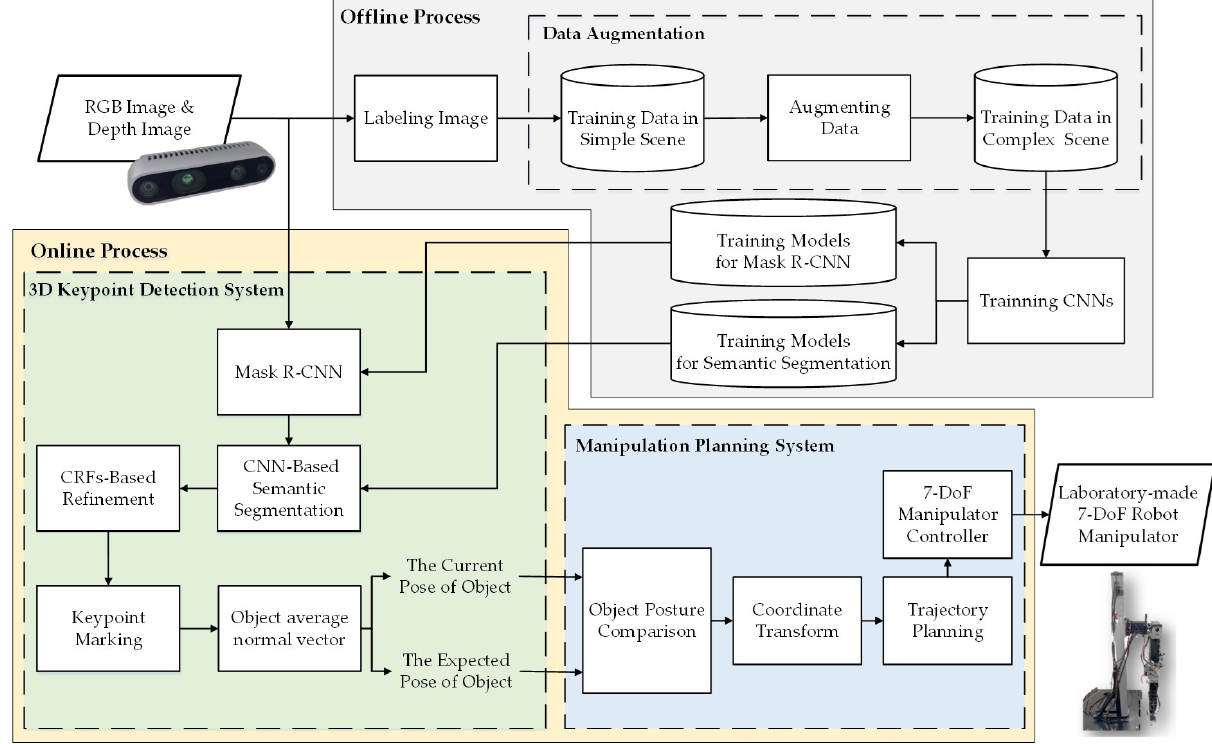
Figure 1. System architecture of the proposed manipulation planning method for object